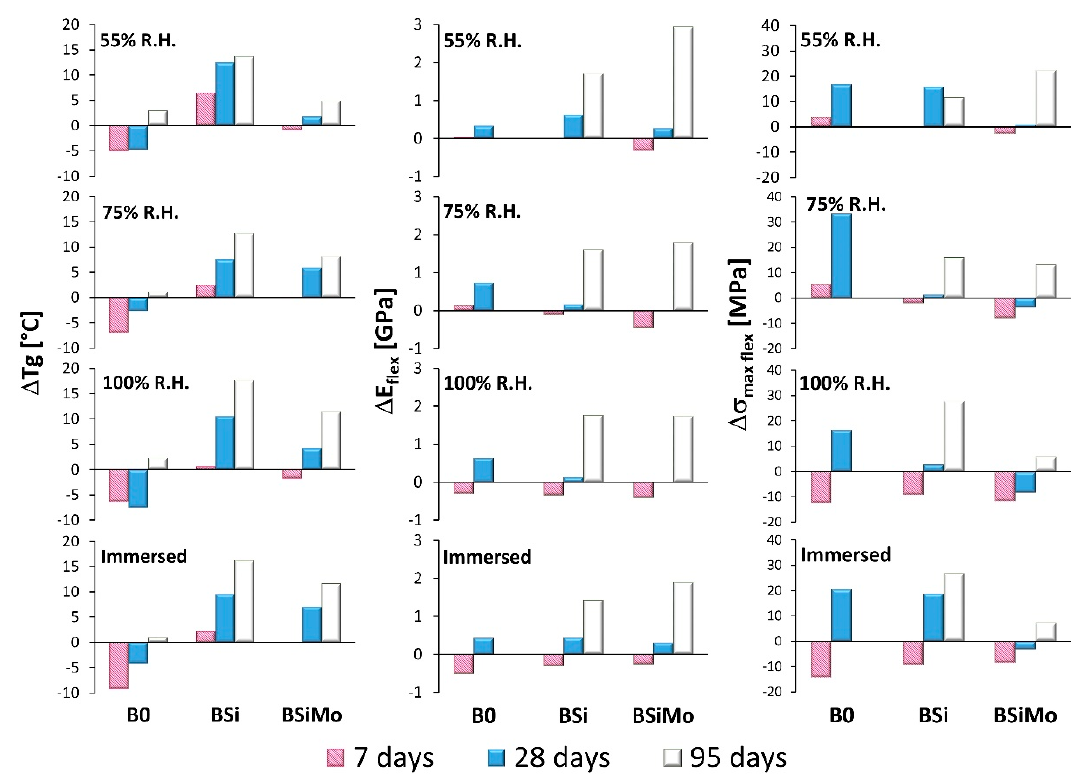
Figure 6. Variations in glass transition temperatures and in flexural mechanical properties (modulus and yield strength) for systems B0, BSi, and BSiMo subjected to different aging procedures for up to approximately three months.